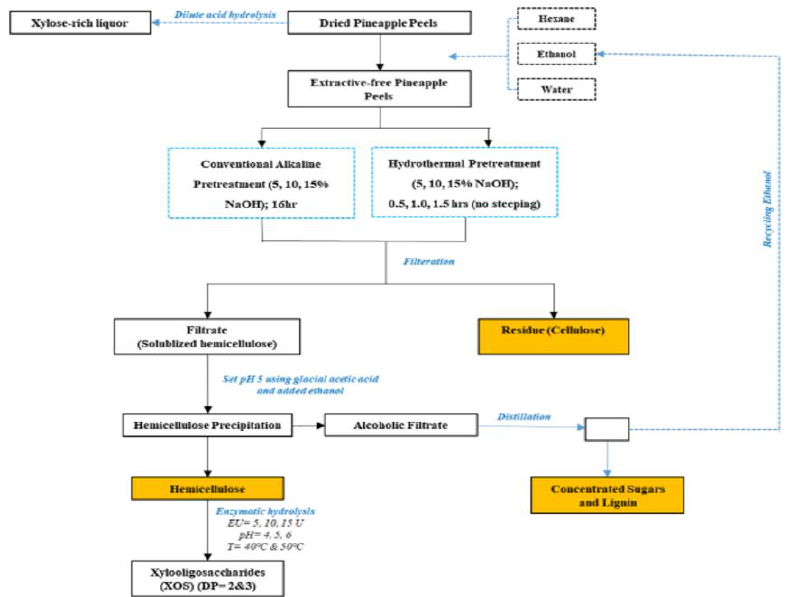
Figure 9. Schematic for extraction of hemicellulose from pineapple peel waste and its valorization into xylooligosaccharides [71].